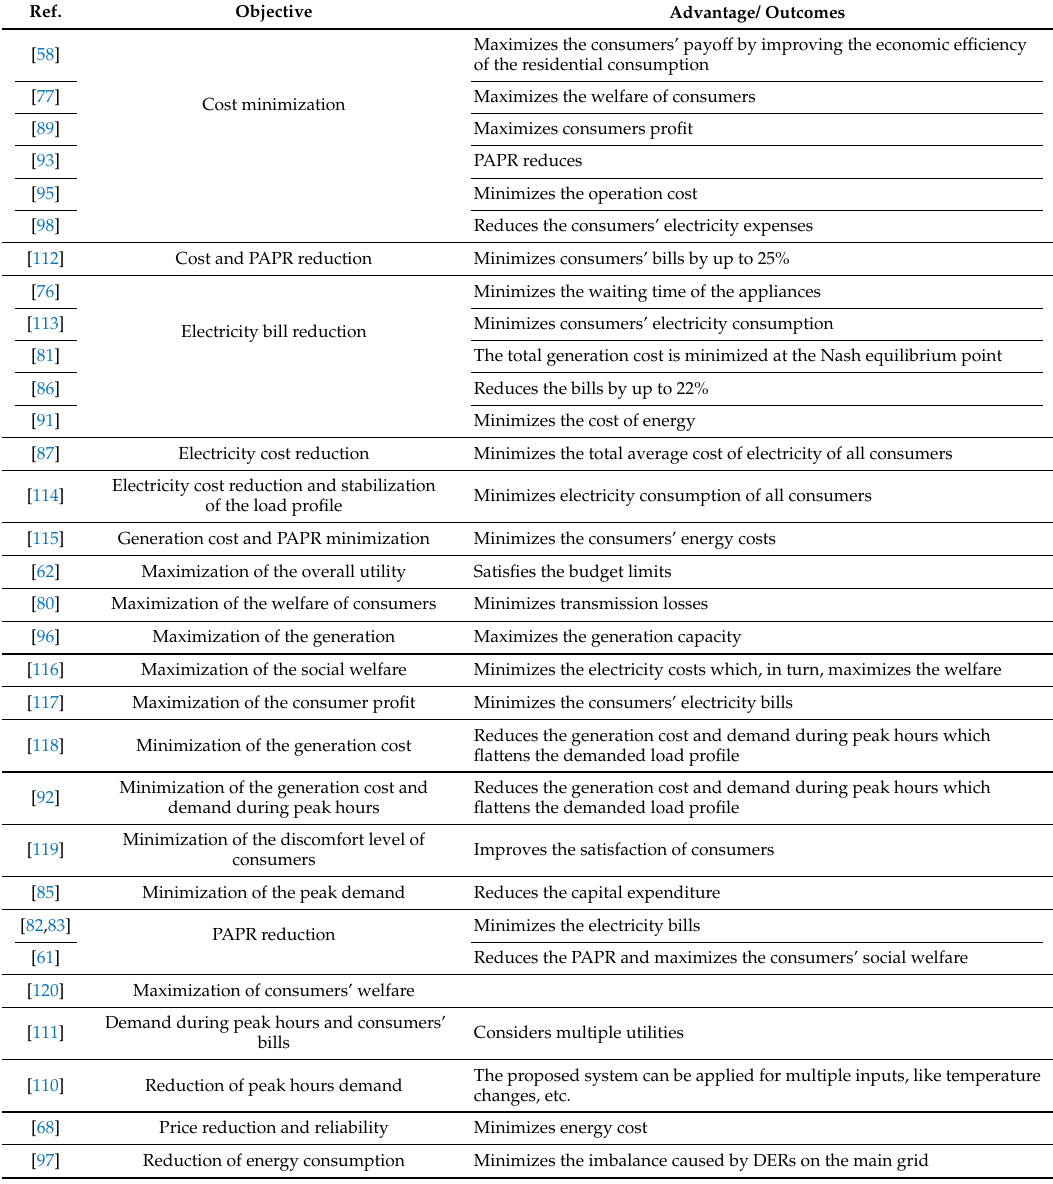
Table 7. Optimization objectives and